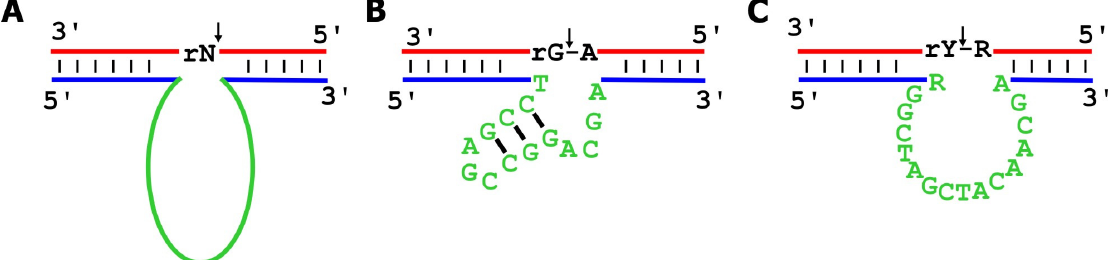
Figure 1. RNA-cleaving deoxyribozymes using a two-binding arm motif. (a) A general structural framework for RNA-cleaving deoxyribozymes that use the two binding arm motif. The deoxyribozyme contains two regions called binding arms (shown in blue) that base-pair to the substrate (shown in red). The RNA cleavage site (indicated with an arrow) is between the two base-paired regions. The catalytic core (shown in green) is opposite the cleavage site. rN represents the ribonucleotide at the cleavage site. (B) Secondary structural model for the 8-17 deoxyribozyme. (C) Secondary structural model for the